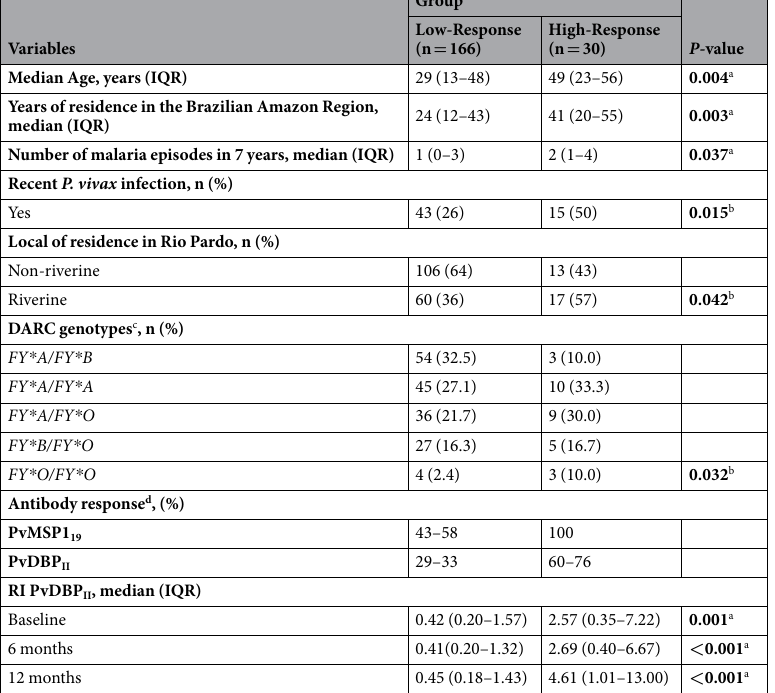
9 SCIENTIFIC RepoRtS | (2018) 8:13851 | DOI:10.1038/s41598-018-32254-z